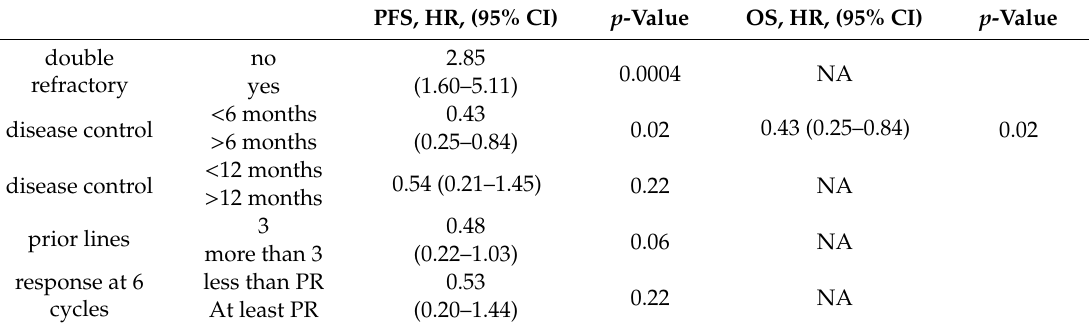
Table 6. Multivariate analysis of PFS and OS at 18 months in RRMM patients treated with